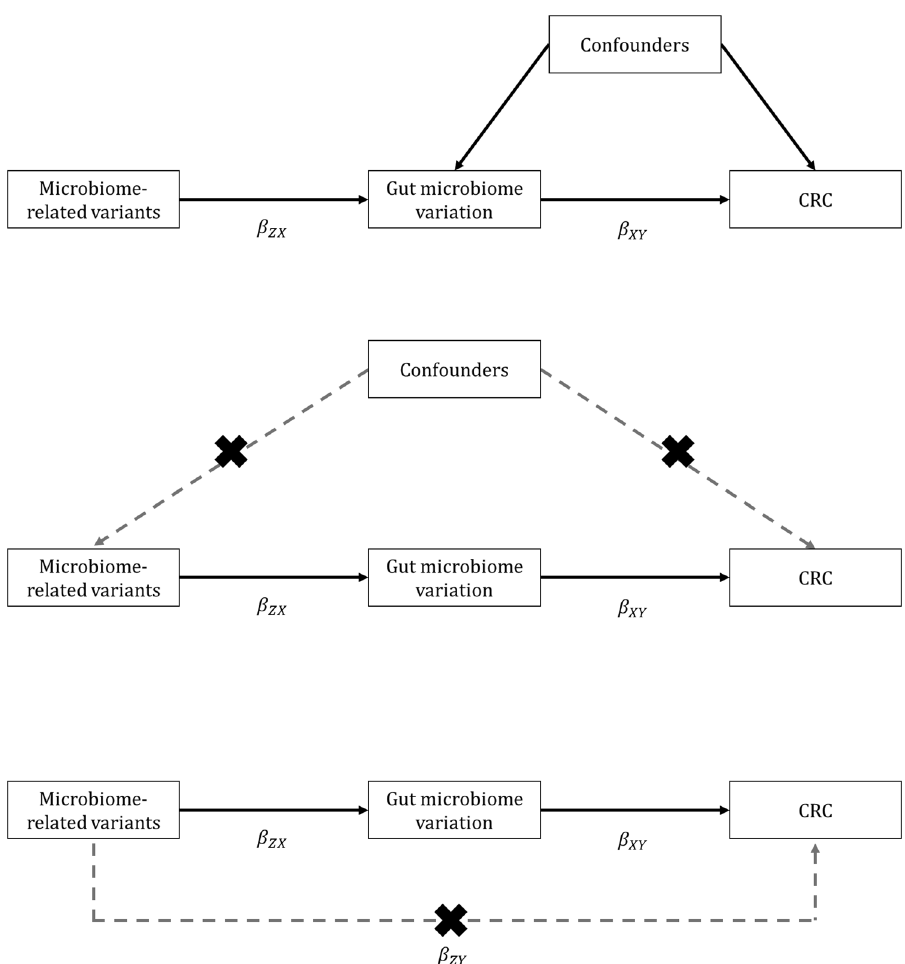
Figure 1. Mendelian randomization framework applied to assess the causal effect of the human gut microbiome on CRC risk. CRC = colorectal cancer; MR = Mendelian randomization; SNP = single nucleotide polymorphism. MR relies on three key assumptions: (top panel) the SNPs are associated with the exposure (here, the gut microbiome); (middle panel) there are no common causes of the SNPs and the outcome (here, CRC), meaning any confounders driven by population substructure, dynastic effects or assortative mating (these may not and are unlikely to be the same confounders of the association between the exposure and outcome); and (bottom panel) the SNPs are not independently associated with the outcome (here, CRC) other than pathways through the exposure (here, the gut microbiome). Given these key assumptions, microbiome-related variants can be used to assess the causal effect of the human gut microbiome on CRC, overcoming limitations of observational epidemiological studies. In two-sample MR analyses, the causal effect of the exposure on outcome ( β XY ) is generated by a ratio of the SNP-outcome ( β ZY ) and the SNP-exposure ( β ZX ) effect estimates derived from two independent